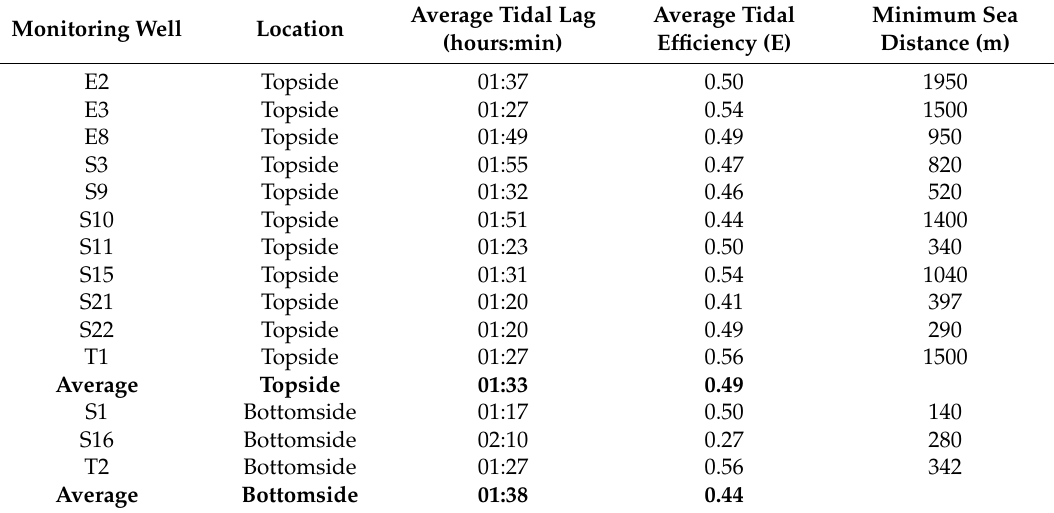
Table 1. Tidal Lag, Efficiency and Distance from the coastline of the monitored monitoring